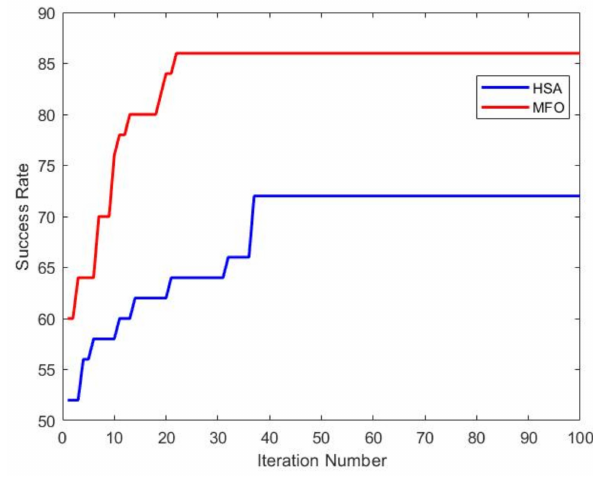
Figure 7. Convergence plot—MFO vs. HSA.